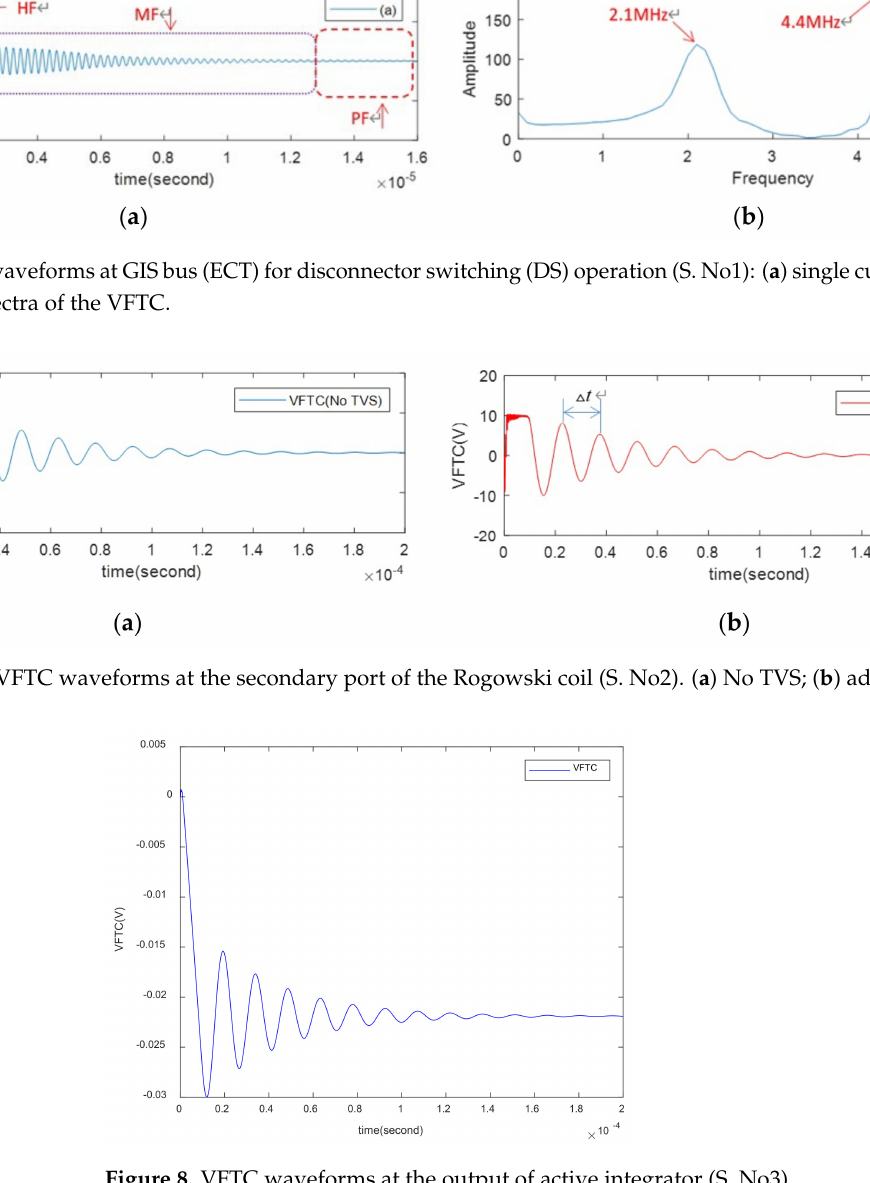
Figure 8. VFTC waveforms at the output of active integrator (S. No3).